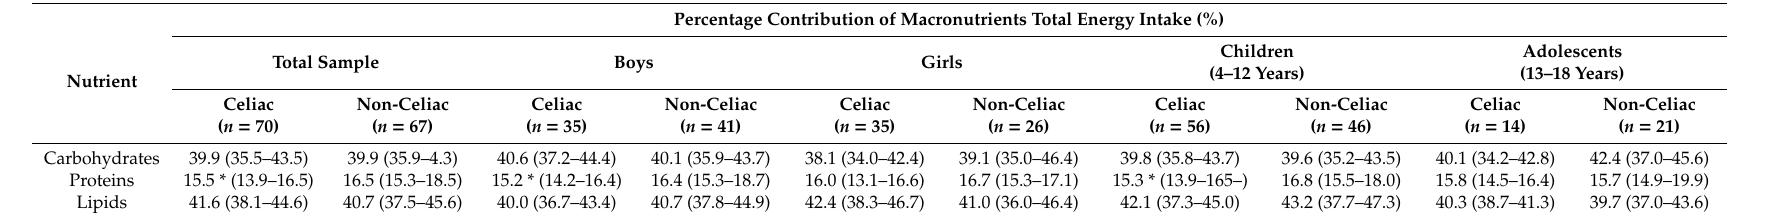
Table 3. Macronutrient distribution in the diet of celiac and non-celiac children and